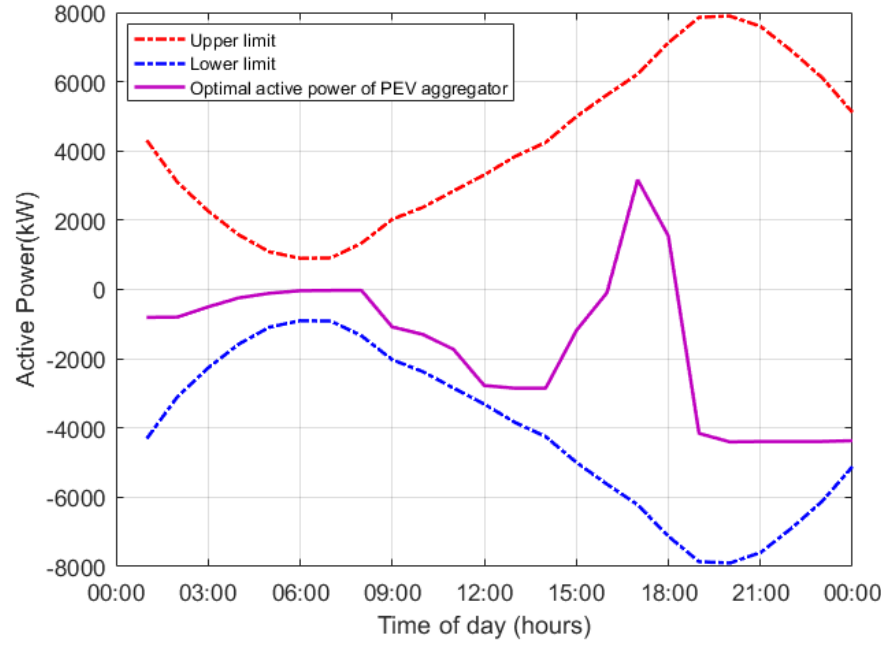
Figure 14. Active power of PEV aggregator and its upper and lower bounds.